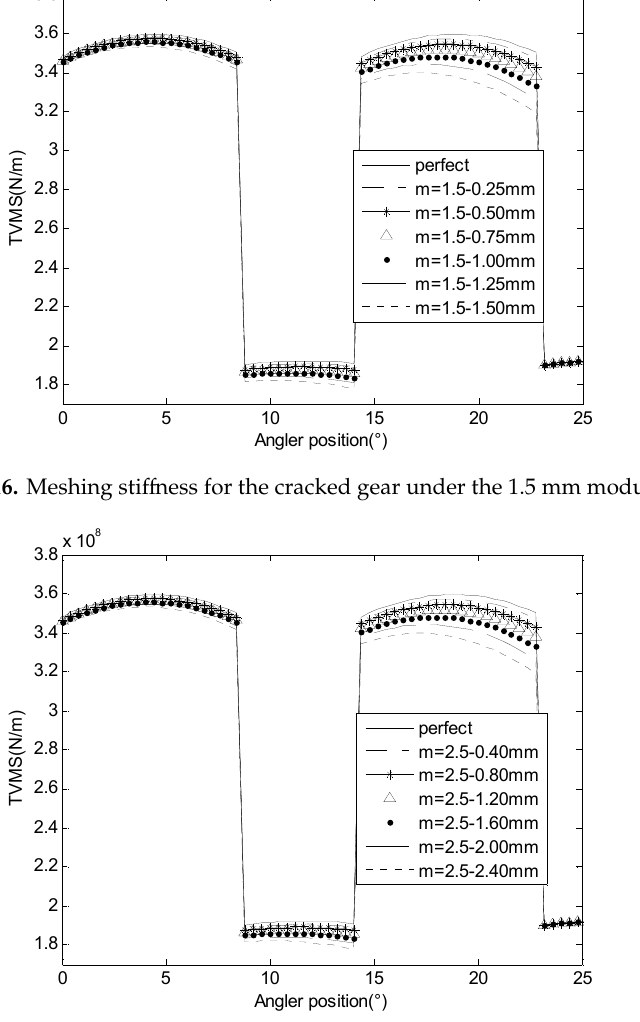
ff ness for the cracked gear under the 2.5 mm Figure 17. Meshing stiffness for the cracked gear under the 2.5 mm modulus. Figure 17. Meshing sti Figure 17. Meshing stiffness for the cracked gear under the 2.5 mm modulus.